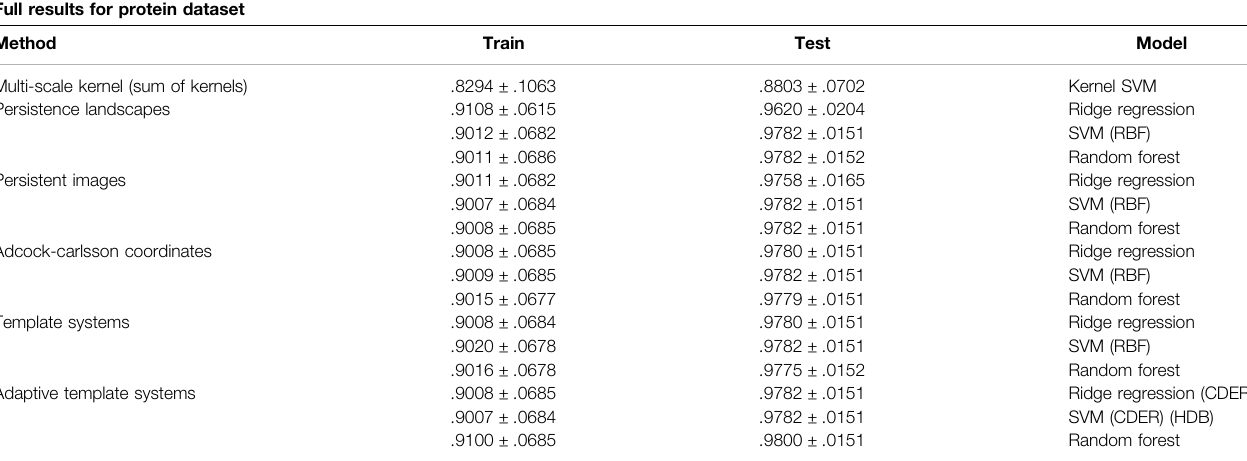
TABLE2| ResultsfromtheProteinDatasetusingtheaveragemodelclassi fi cationaccuracy ± standarddeviationover54trialscorrespondingtotheprede fi nedindicesofthe dataset. Full results for protein